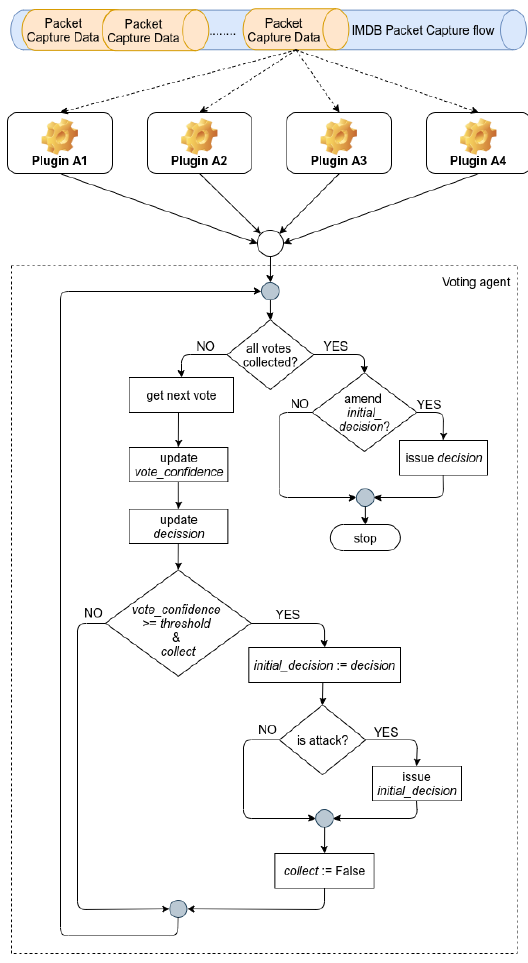
Figure 3. ECAD voting